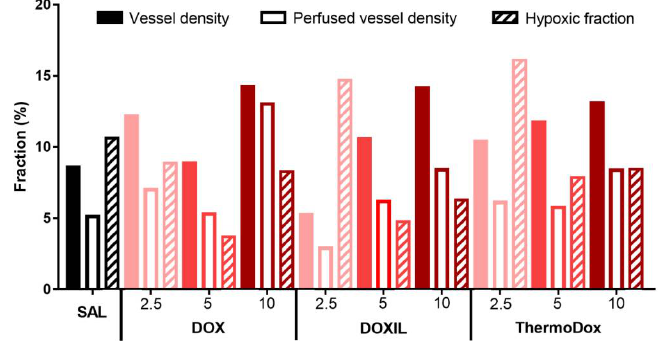
Figure 7. Vessel density, perfused vessel density, and hypoxic fraction. For each tumor, the vessel density (closed bars), the perfused vessel density (open bars), and the hypoxic fraction (striped bars) were determined in the whole tumor section.